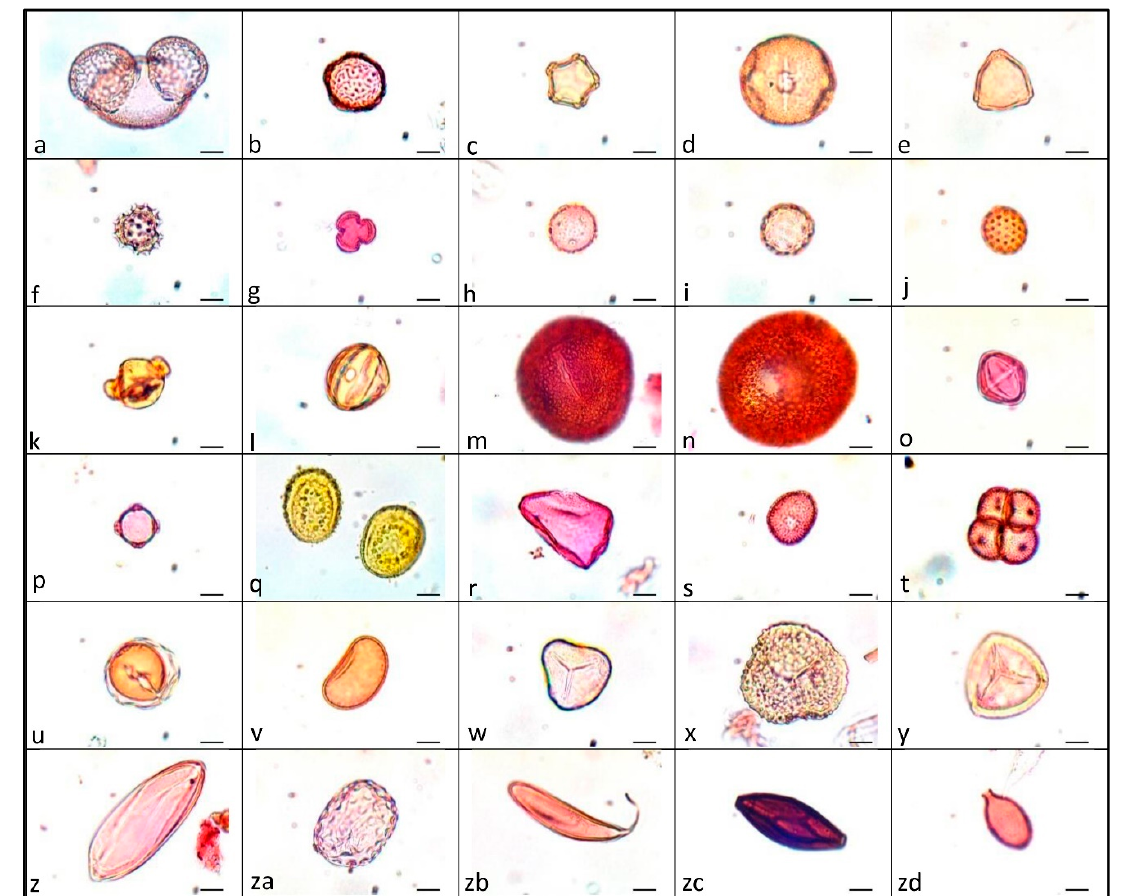
Figure 6. Selected samples of regional and local pollen, spores and non-pollen palynomorphs from the Blatuša mire. The scale bar is 10 μ m: Arboreal pollen taxa : ( a ) Pinus , ( b ) Ulmus , ( c ) Alnus , ( d ) Fagus , ( e ) Corylus ; Non-arboreal pollen taxa : ( f ) Matricaria type, ( g ) Artemisia , ( h ) Plantago lanceolata type, ( i ) Plantago major-media type, ( j ) Chenopodiaceae; Local pollen taxa : ( k ) Circaea , ( l ) Lythrum , ( m ) Succisa type, ( n ) Geranium , ( o ) Sanguisorba officinalis ; Local hydrophyte taxa : ( p ) Myriophyllum , ( q ) Nymphaea , ( r ) Cyperaceae , ( s ) Sparganium type, ( t ) Typha latifolia type; Local plant spores : ( u ) Equisetum , ( v ) Polypodiales, ( w ) Pteridium , ( x ) Anthocerotidae, ( y ) Sphagnum ; Non-pollen palynomorphs : Algae: ( z ) Spirogyra , ( za ) Zygnema ; Copepod remains: ( zb ) spermatophore; Fungi: ( zc ) Diporotheca webbiae ; Unknown origin, probably euglenophytes( zd ) HdV 179.